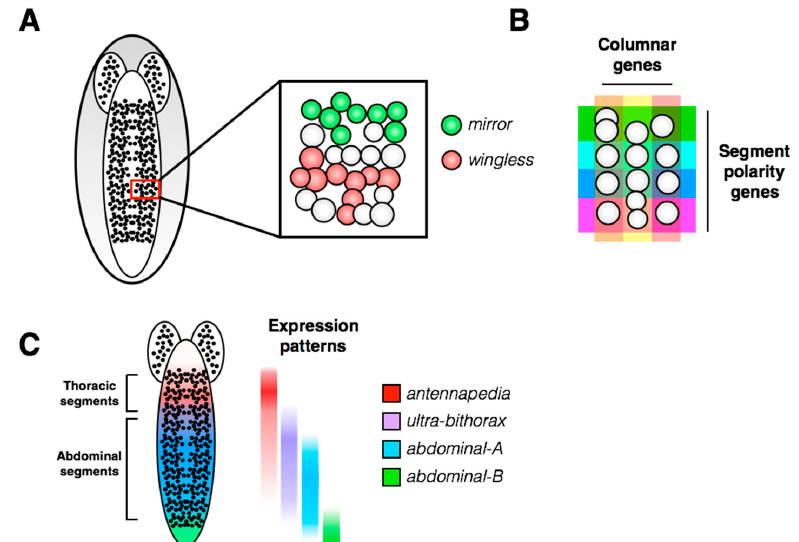
Figure 3. Spatial patterning of the Drosophila ventral nerve cord. ( A ) A single hemisegment containing approximately 30 neuroblasts is shown in the inset. Gene expression is patterned within the hemisegment: two examples of spatially restricted molecular markers are shown ( mirror and wingless ; from the Hyper-Neuroblast Map, Doe laboratory). ( B ) Upon delamination from the neuroectoderm, neuroblast identity is specified within a hemisegment by a Cartesian grid generated by expression patterns of the columnar and segment polarity genes (reviewed in [16]). ( C ) Along the anterior-posterior axis of the embryo, hemisegment identity is also subject to spatial regulation by the Hox gene family. All of these spatial patterns are superimposed in vivo , providing each neuroblast with a unique spatial identity.